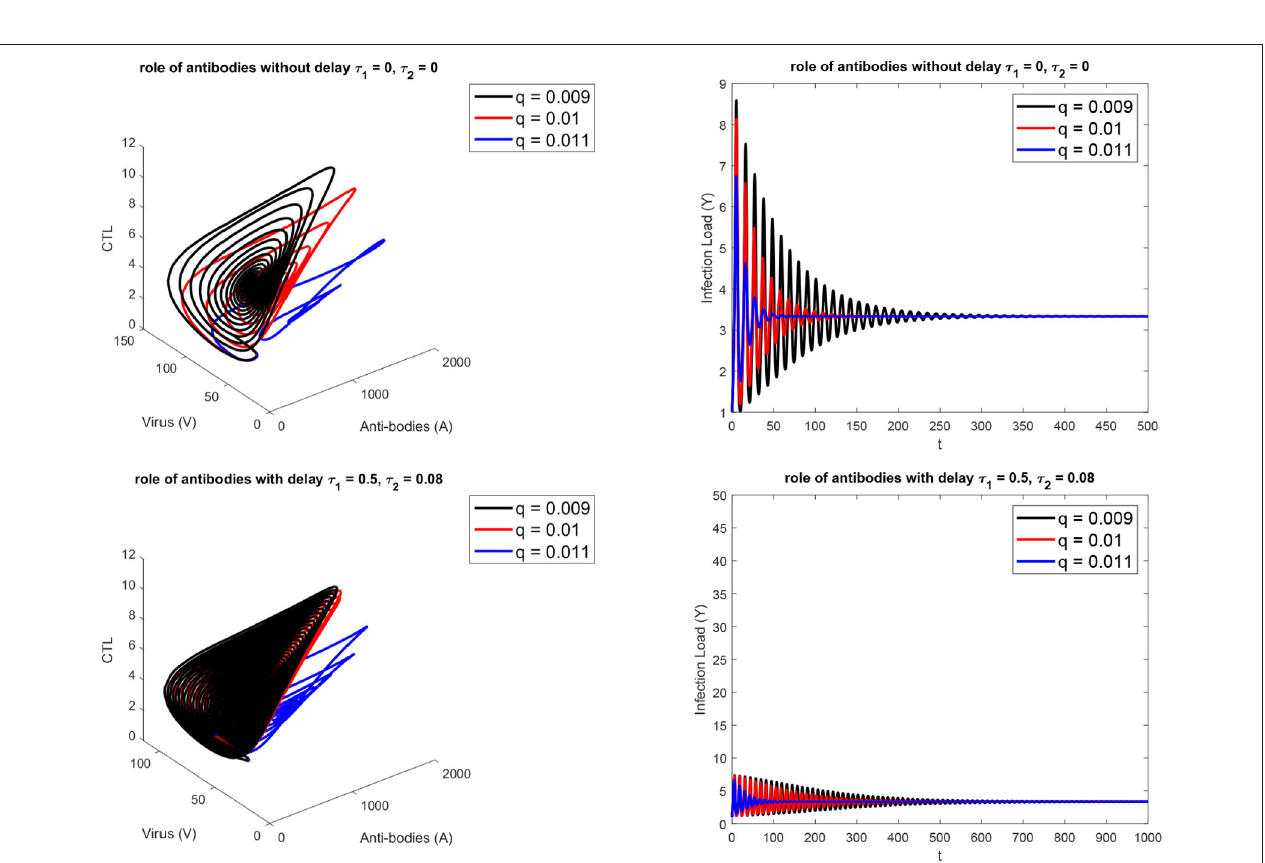
FIGURE 2 | For three different values of antibody-SARS-2 interaction rates ( q ). (Top) without, (Bottom) with delay τ 1